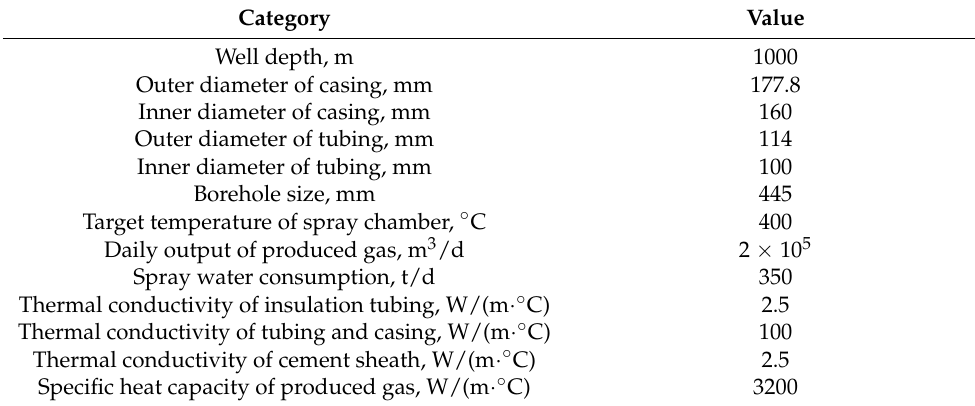
Table 1. Parameters of wellbore structure and working conditions.